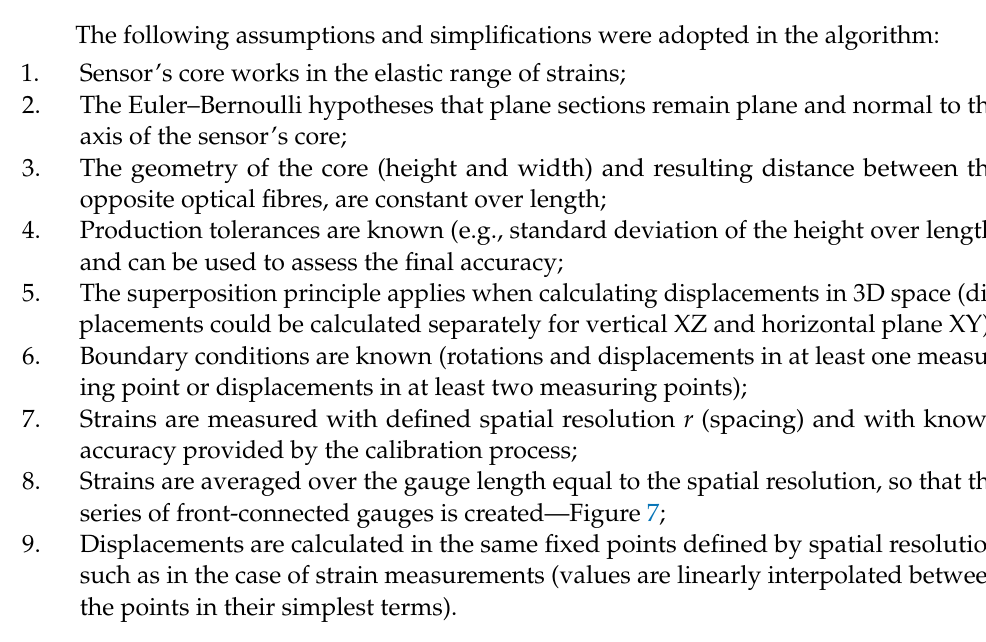
Figure 6. Definition of mathematical–physical problem for calculating 3D displacements based on strain data measured by 4 optical fibres with defined spatial resolution.